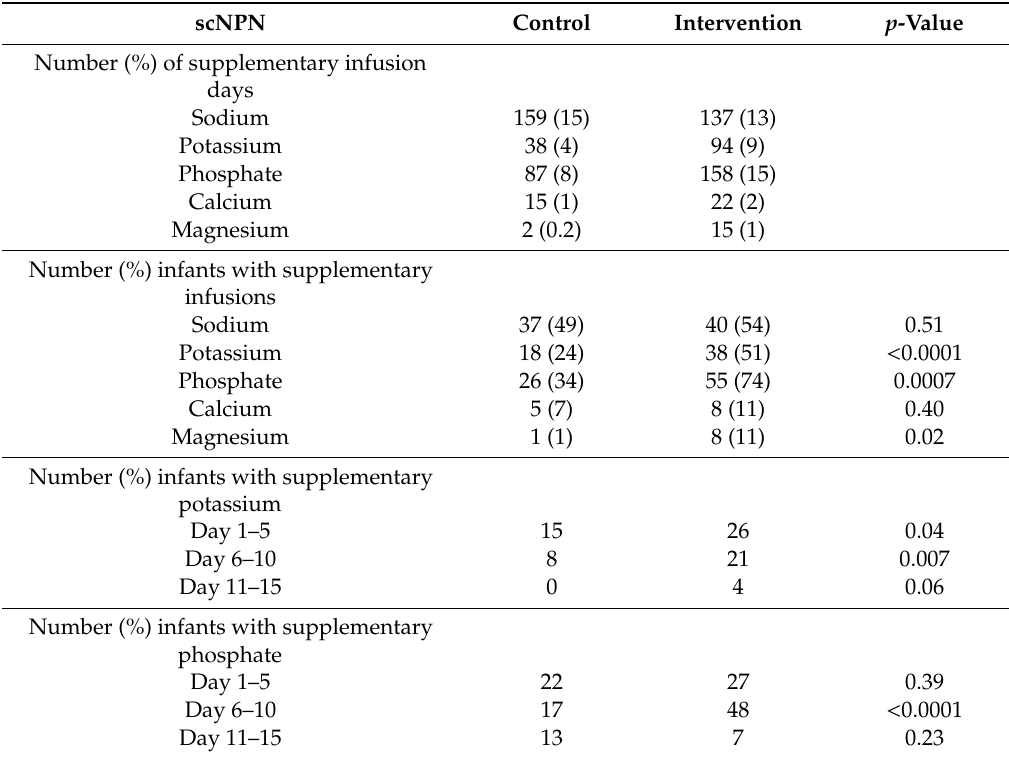
Table 5. Comparison of standardised supplementary electrolyte infusion usage in control and intervention scNPN